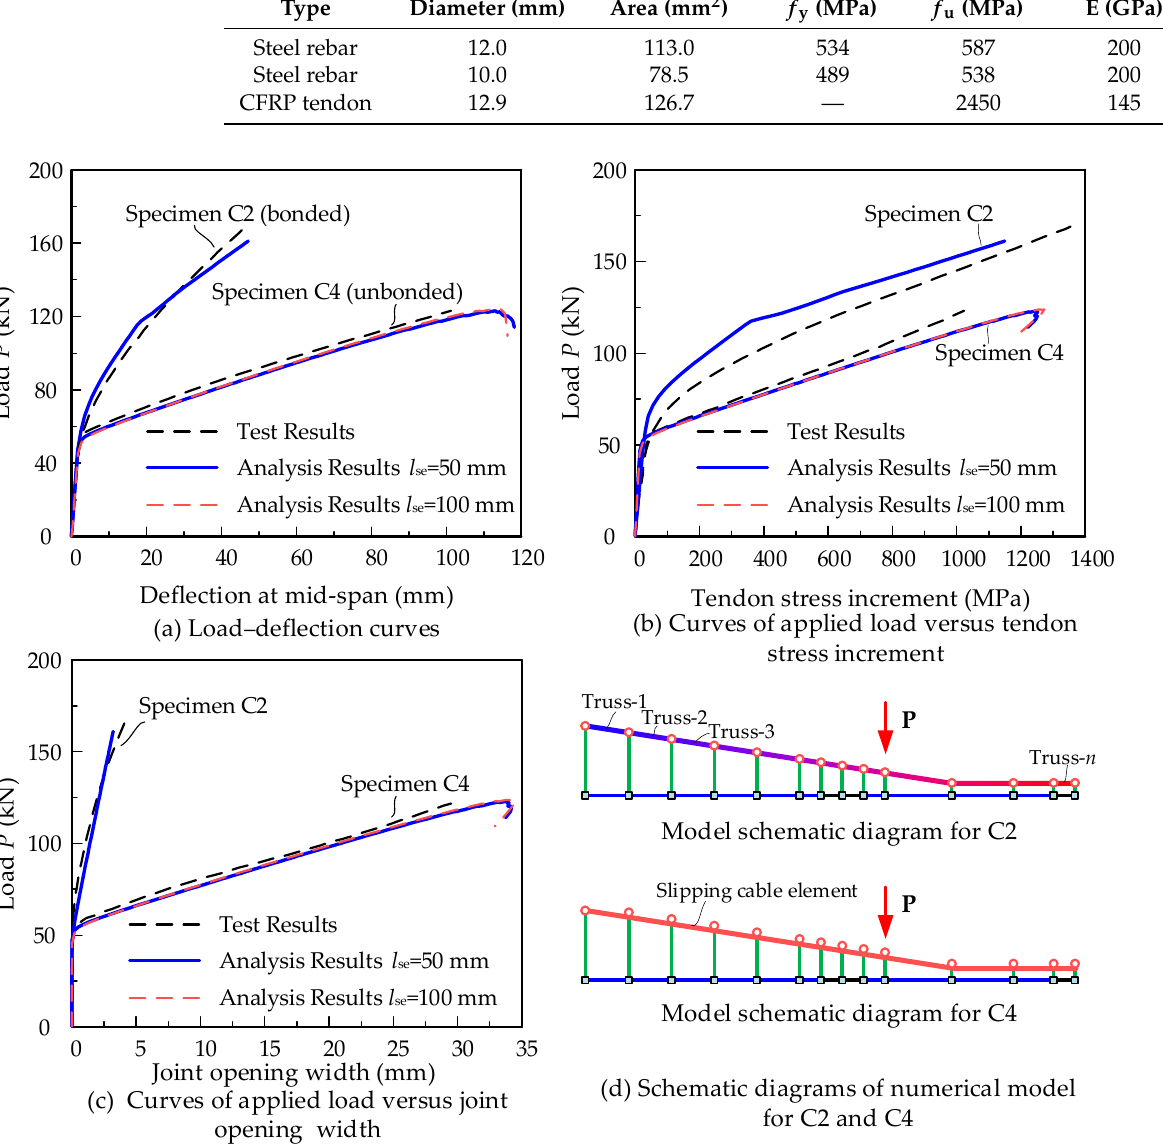
Figure 11. Analysis results for specimens C2 and C4.